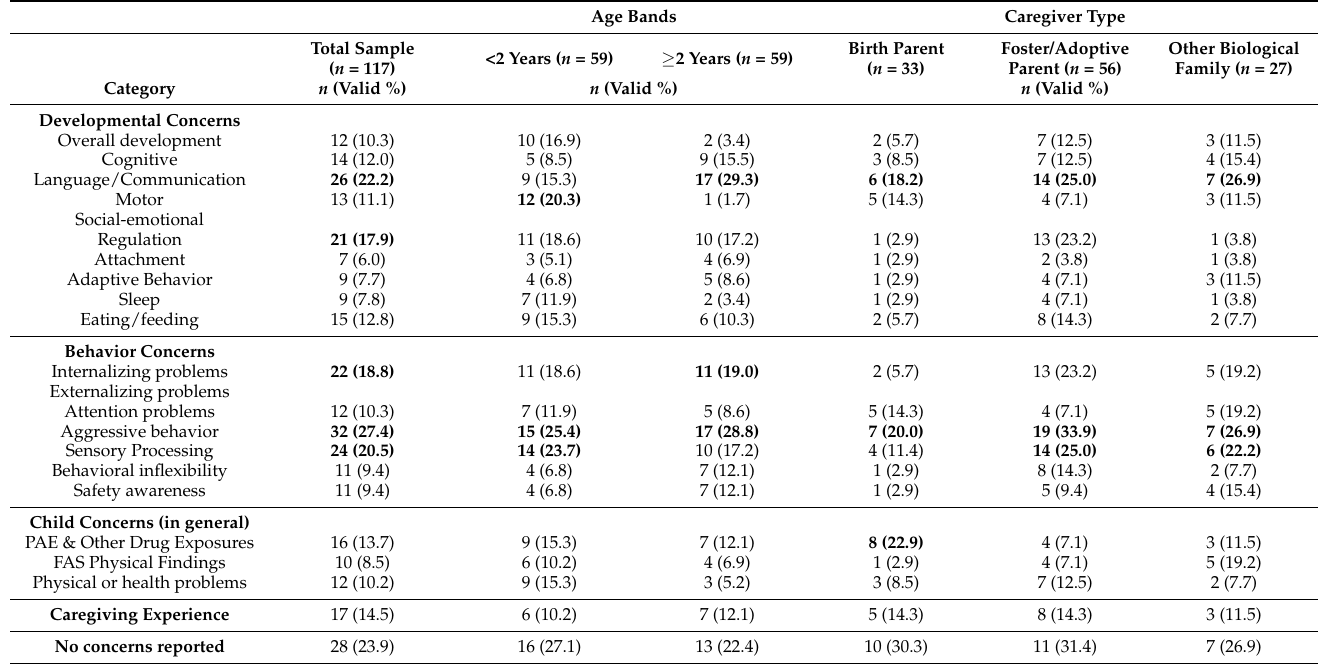
Table 2. Prevalence of reported